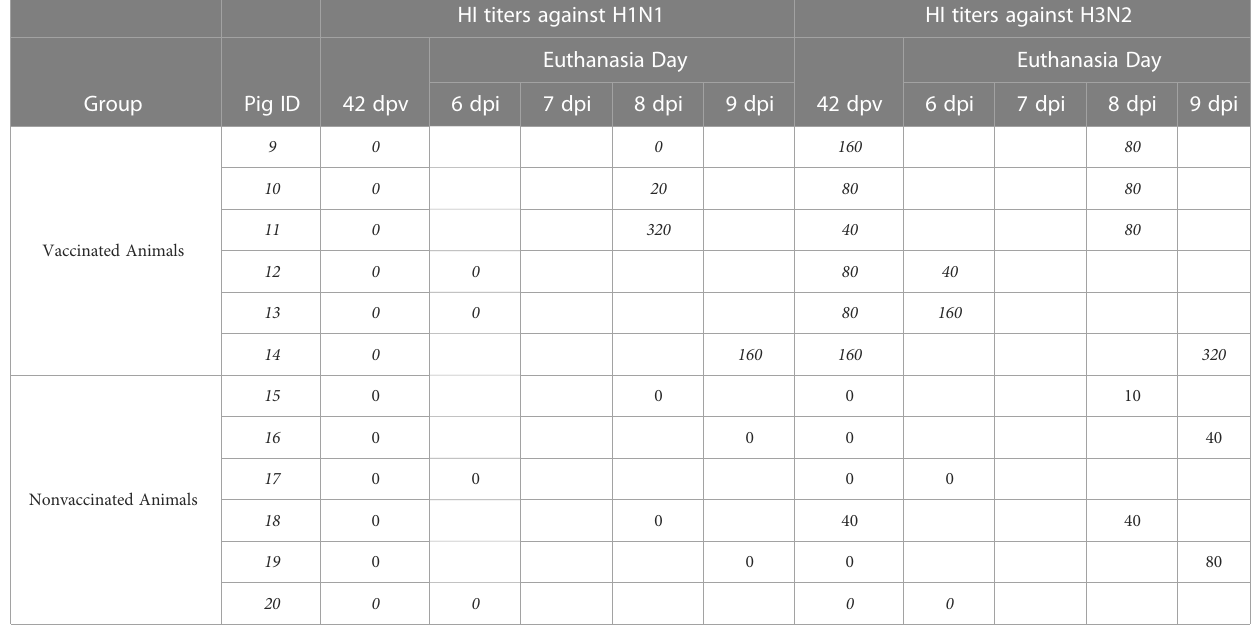
TABLE 1 HI titers of sera samples collected from vaccinated and nonvaccinated animals against H1N1 (left) and H3N2 (right) strains used on the challenge.